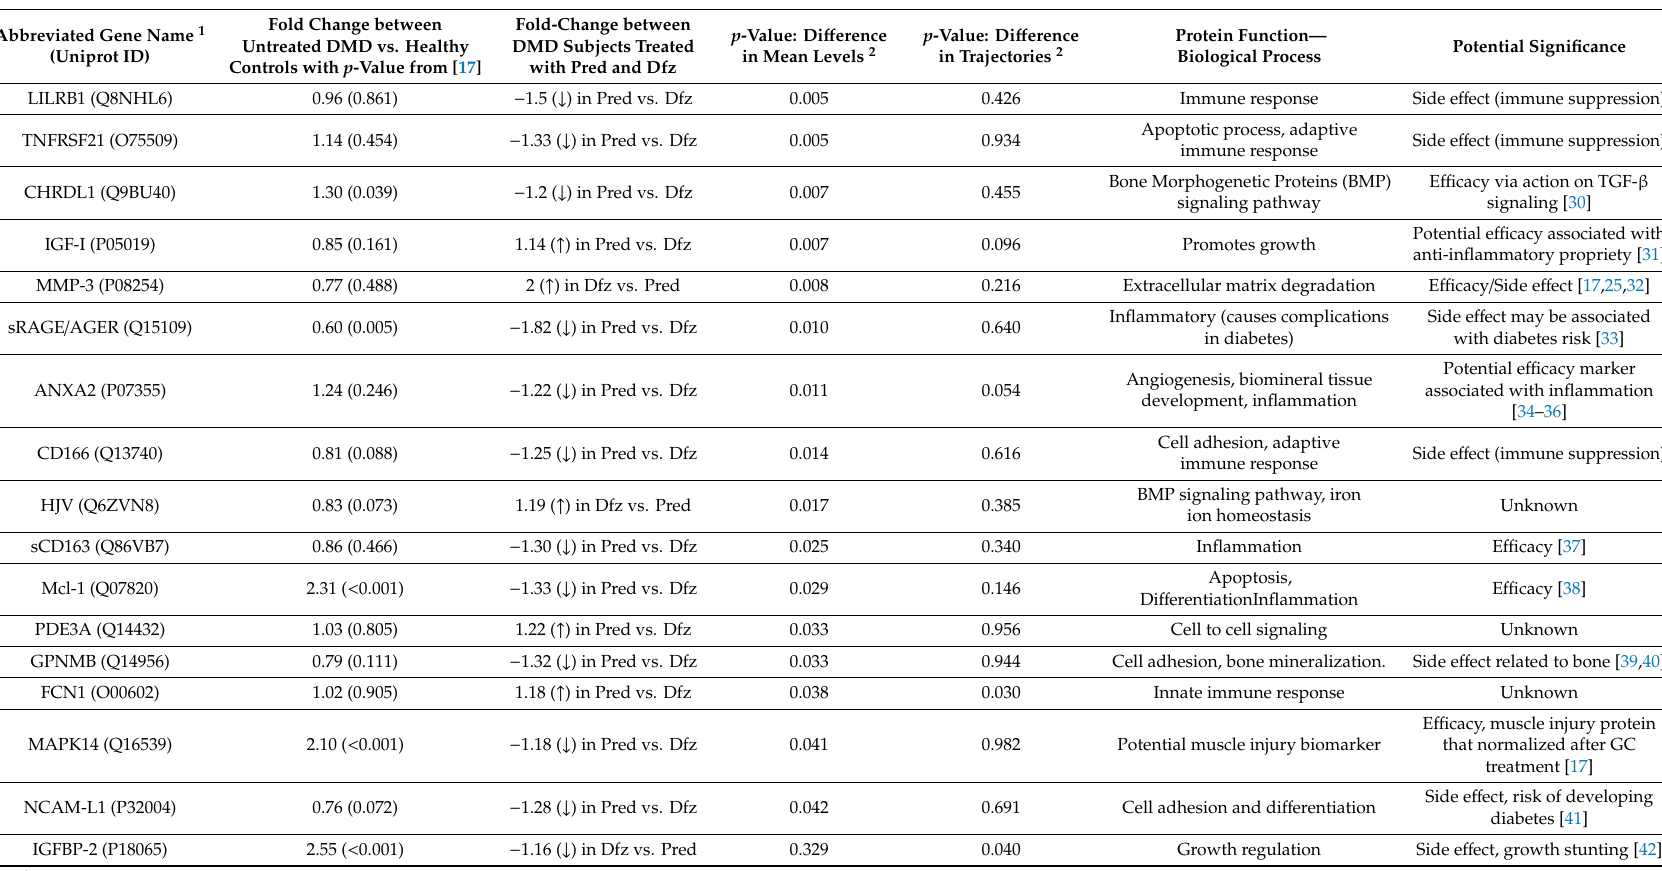
Table 3. List of PD biomarkers that were di ff erentially altered between Pred-treated ( n = 7) and Dfz-treated ( n = 8) groups (SOMAscan ® screening dataset A). Abbreviated Gene Name 1 (Uniprot